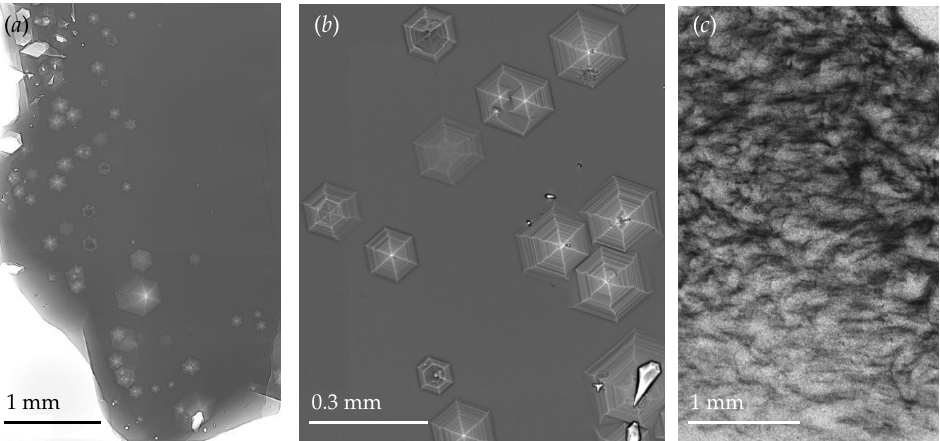
Figure 3. ( a , b ) SR X-ray phase contrast images of freestanding AlN layer shown in Figure 2c. The voids are imaged at a distance of 17 cm behind the specimen; ( c ) SR X-ray diffraction topograph of the same specimen recorded using white radiation in transmission setting. Film Kodak